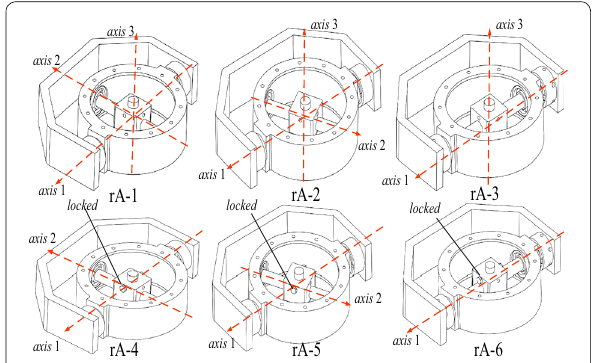
Figure 3. The six phases of rA joint